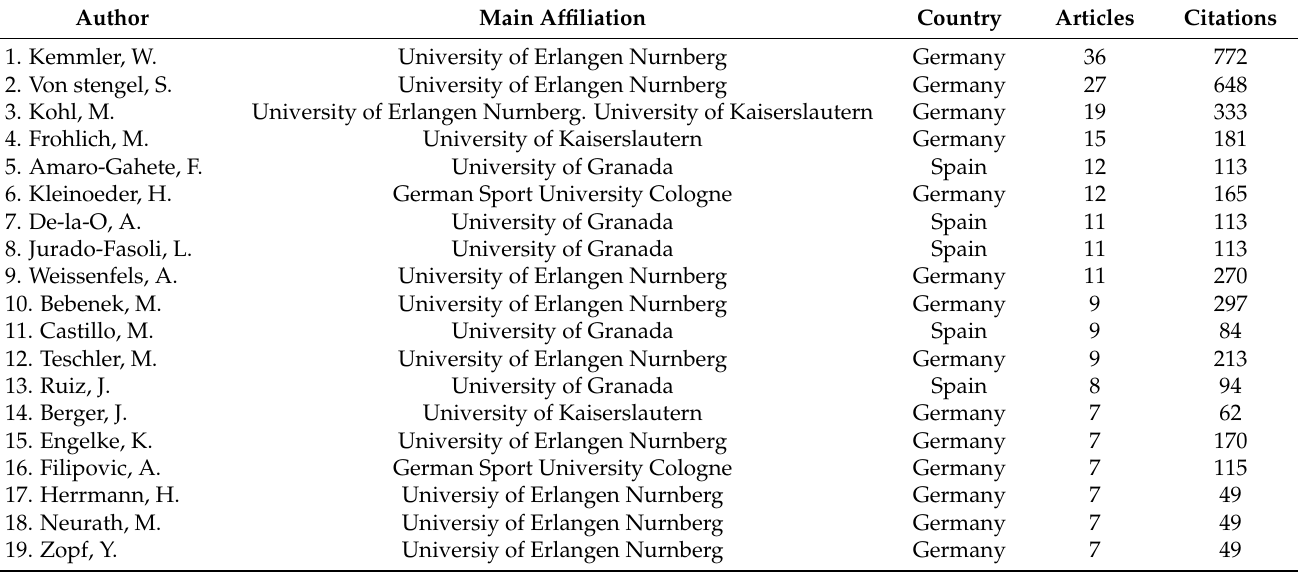
Figure 2. Histogram of publications per author on WB-EMS. According to Lotka’s law, it was estimated that the prolific authors should be the 17 with the highest number of publications (square root of 298). Then, 19 authors with the most published articles were considered the prolific authors: 13 authors with 8 or more publications + 6 authors with seven publications (Table 2). Table 2. Co-author prolific on WB-EMS.